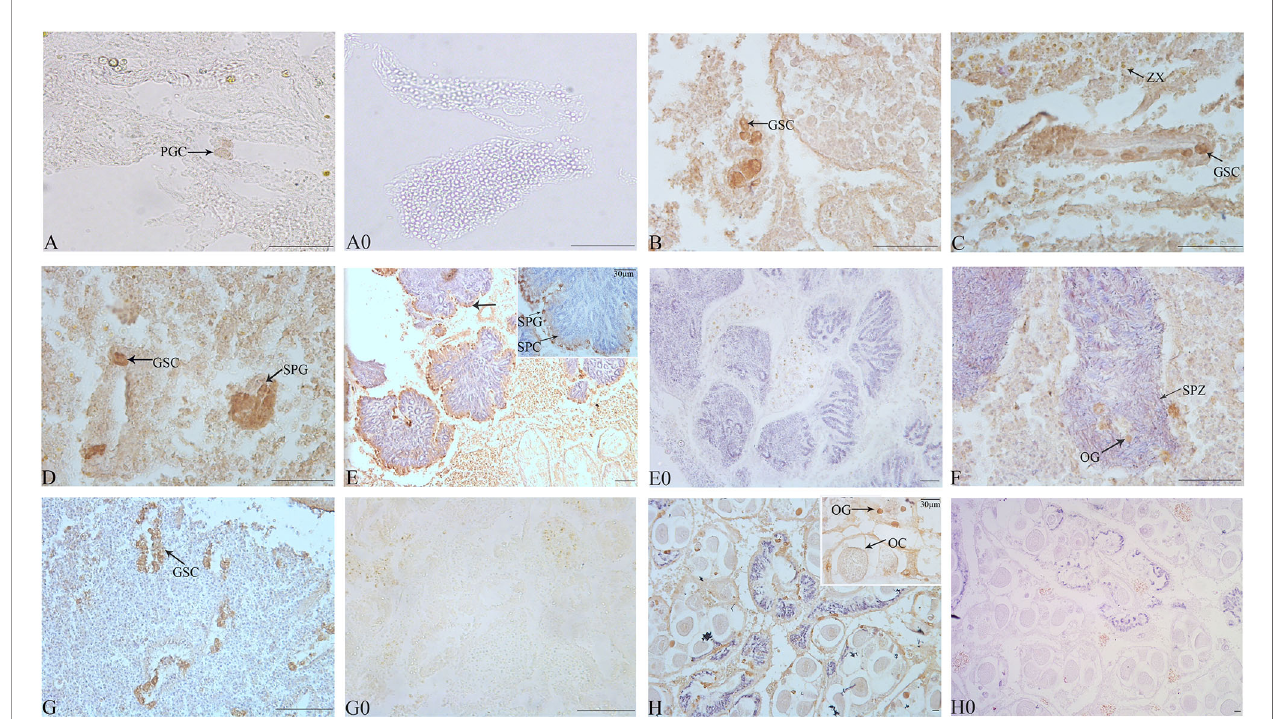
FIGURE 6 | Observation of the gonad at the early development of juvenile T. crocea by immunohistochemistry. (A – H) The immunohistochemistry of gonads of T. crocea at 5, 6, 8, 10, 12, 17, 21, and 25 months, respectively. Germ cells speci fi cally stained by anti-Tc-Piwi1 antibody are in dark brown. The sections incubated without the primary antibodies did not show any immunostainings (A0, E0, G0, and H0). The cells in histological sections include primordial germ cells (PGC), germ stem cells (GSC), spermatozoa (SPZ), spermatocyte (SPC), spermatogonia (SPG), oocyte (OC), oogonia (OG), and symbiotic dino fl agellates (zooxanthellae (ZX)). Scale bar = 20